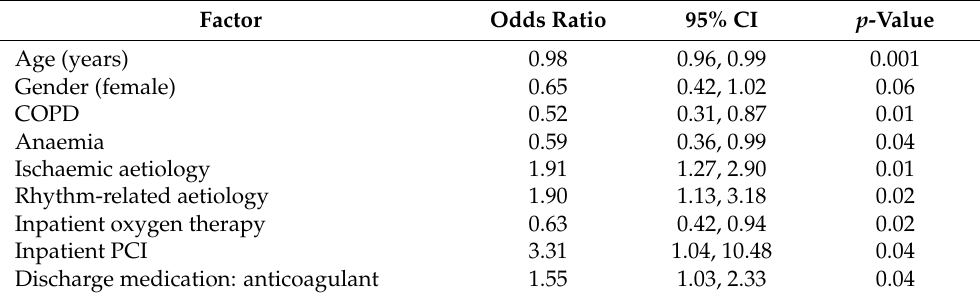
Table 2. Factors associated with referral to cardiac rehabilitation at time of discharge among all patients with HF.